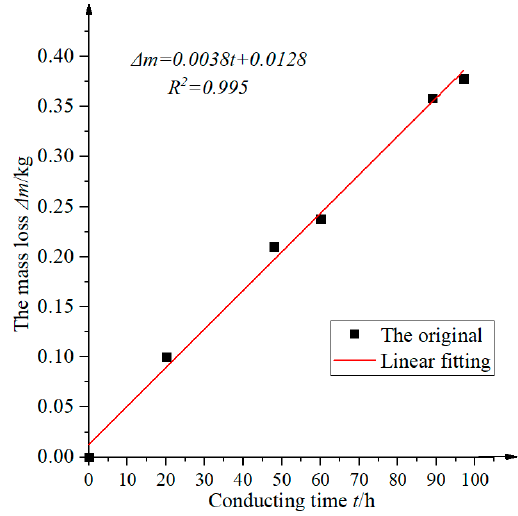
Figure 4. The relationship between the mass loss and conducting time.